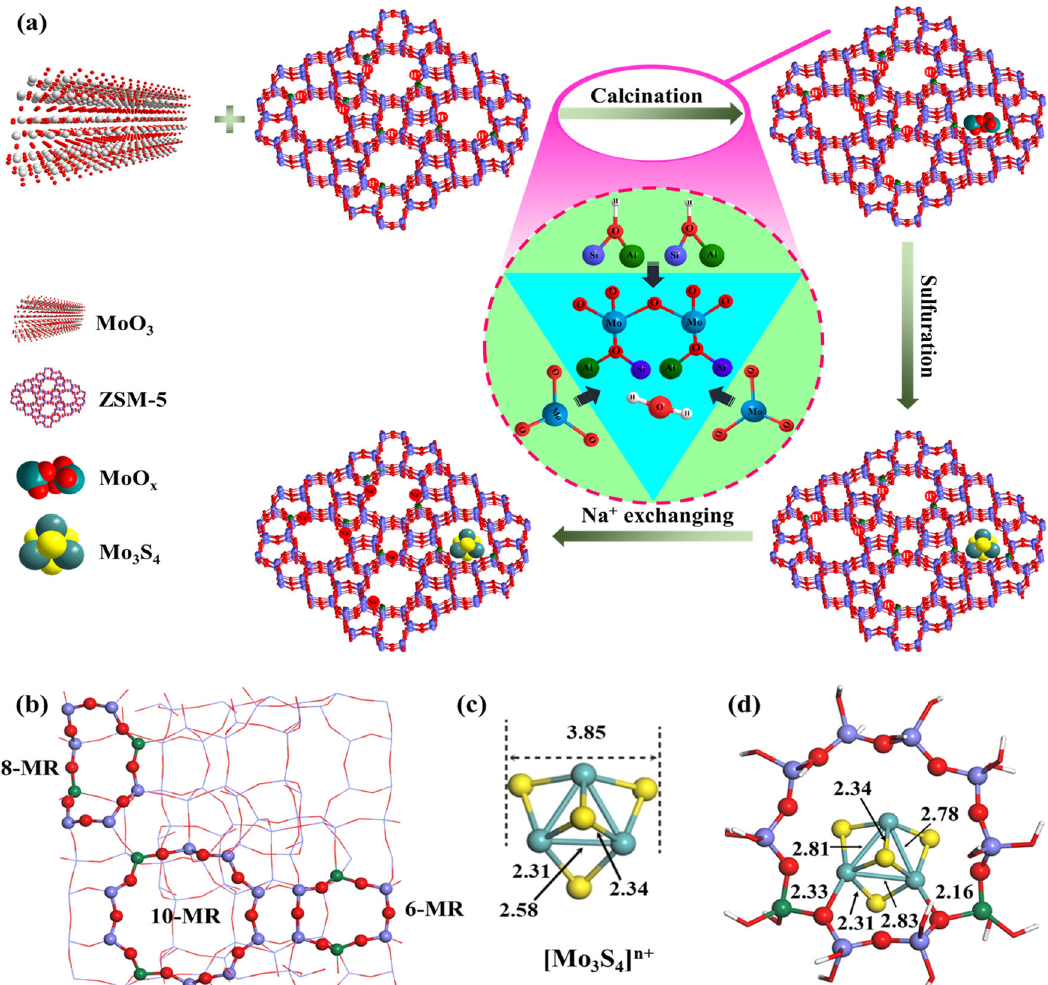
Fig.1|SchematicdiagramofcatalystsynthesisandstructureoptimizedbyDFT calculations. a Preparation of Mo 3 S 4 @NaZSM-5 (the shaded region refers to the scheme of solid exchange of MoO 3 with OH groups in HZSM-5, the positions of aluminum and proton are schematically shown.); b The zigzag 10-MR(T3/T3), 8-